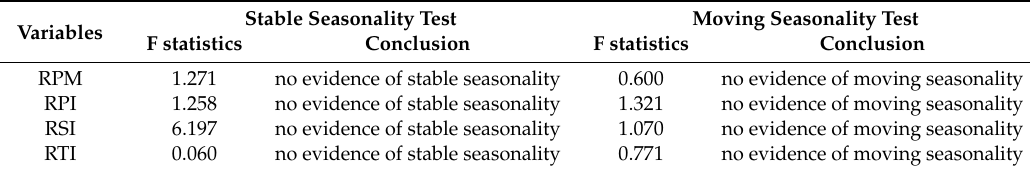
Table 1. Seasonal Test